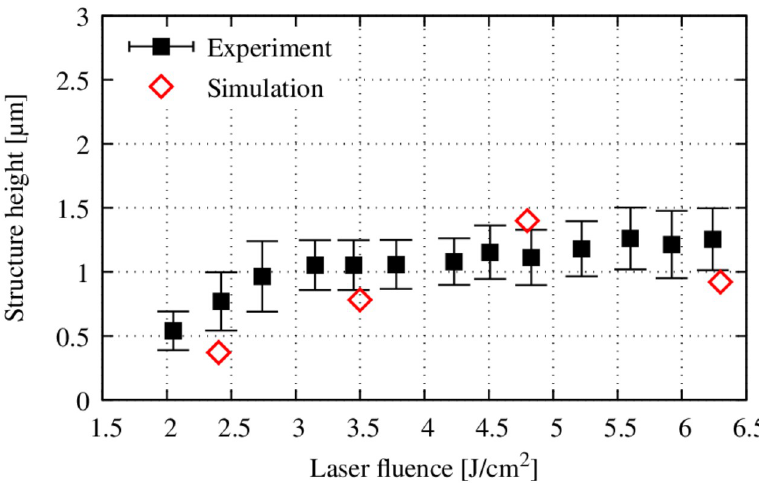
Fig 12. Comparison of simulated and measured structure heights with radial polarization orientation of the laser beam. Experimental data from Voisiat et al. [25].